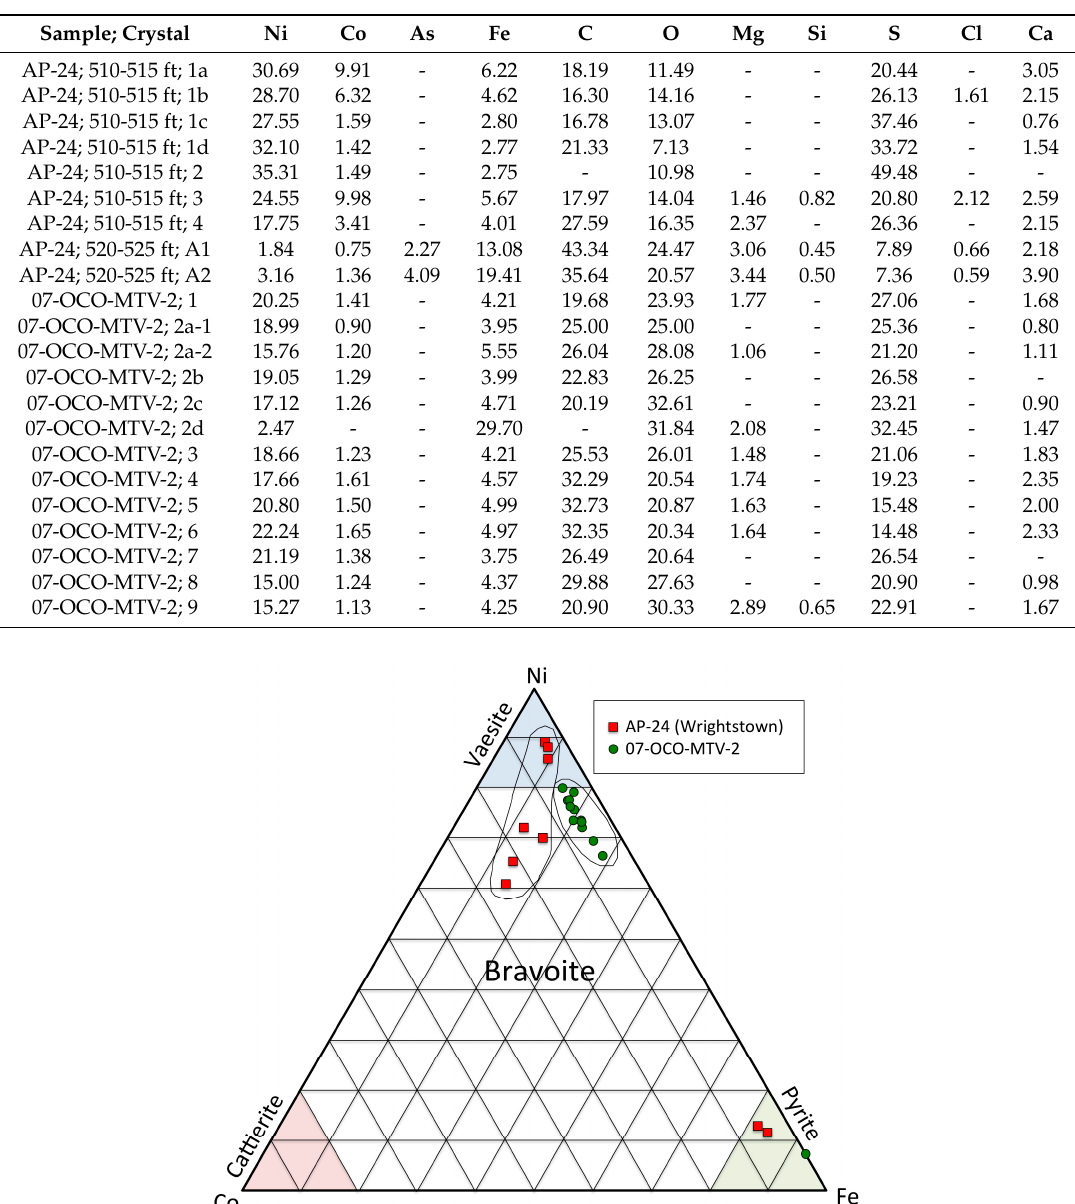
Table 1. Concentrations of elements in selected crystals of Ni-Co-Fe-As-sulfide minerals from Brown and Oconto Counties. Values are reported in weight % generated from the EDAX Software. Sample AP-24 refers to the Village of Wrightstown Test Well in Brown County (Locality 83). Designations 1a, 1b, etc. refer to analysis points broadly from the core to the rim of crystal 1. Sample 07-OCO-MTV-2 refers to the Montevideo quarry in Oconto County (Locality 39). Dashes indicate no detection by the software.